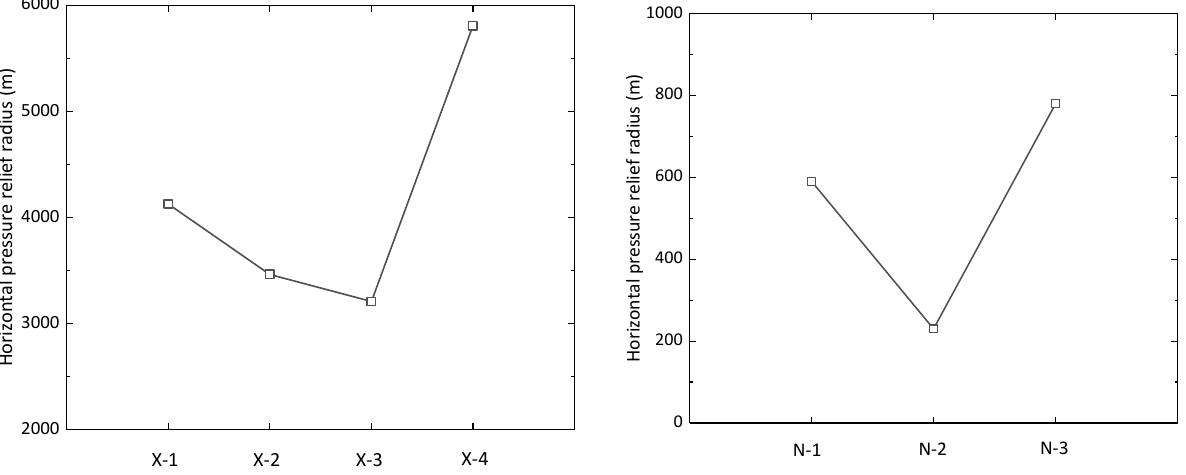
Processes 2023 , 11 , x FOR PEER REVIEW Figure 12. Permeability comparison between well blocks X and N. Figure 12. Permeability comparison between well blocks X and N.